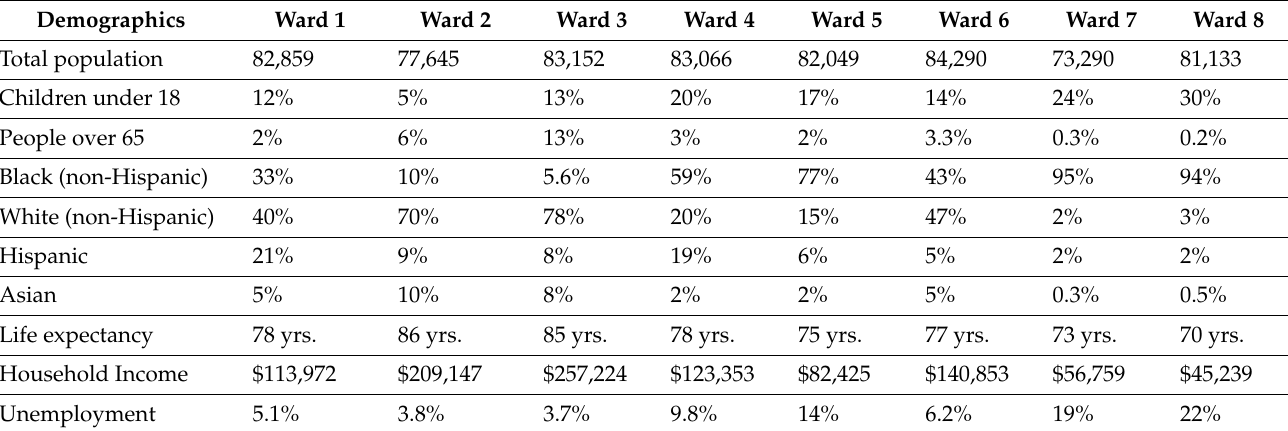
Table 1. Demographics of Washington, D.C. by Ward